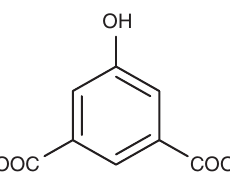
hip linkers employed in 3